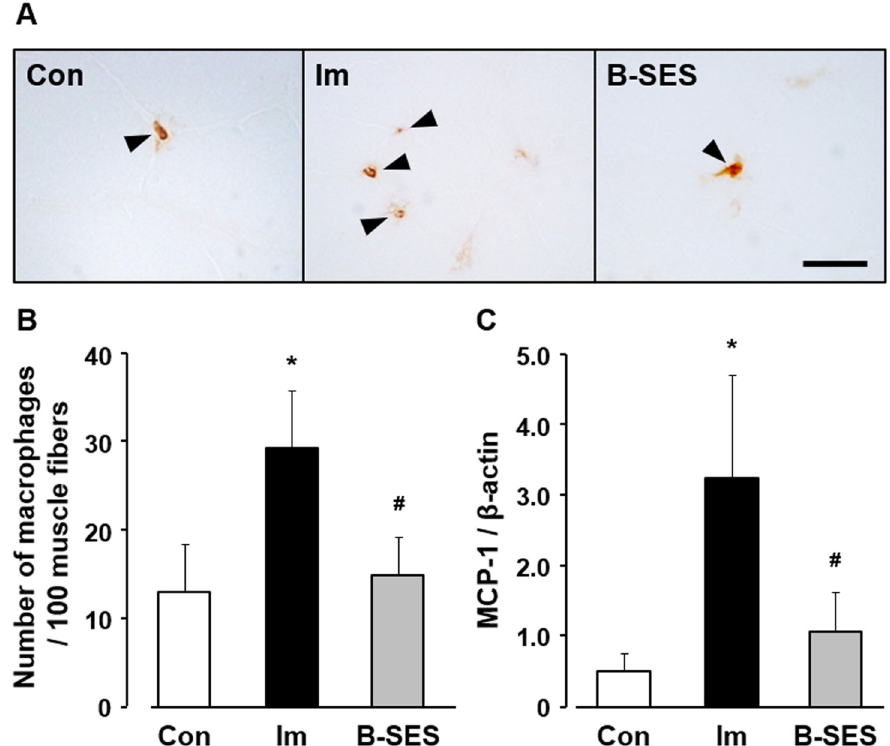
Fig 6. Macrophages number and MCP-1 mRNA expression in soleus muscles. (A) Immunohistochemical staining for CD-11b in soleus muscles. Arrowheads indicate the CD-11b-positive cells. Scale bar, 20 μ m. (B) Number of CD- 11b-positive cells per 100 myofibers. (C) Relative expression of MCP-1 mRNA. Open bars represent the control group (Con). Black bars represent the immobilization group (Im). Gray bars represent the belt electrode-skeletal muscle electrical stimulation group (B-SES). Data presented as mean ± standard deviation. � , Significant difference (p < 0.05) compared with the control group.